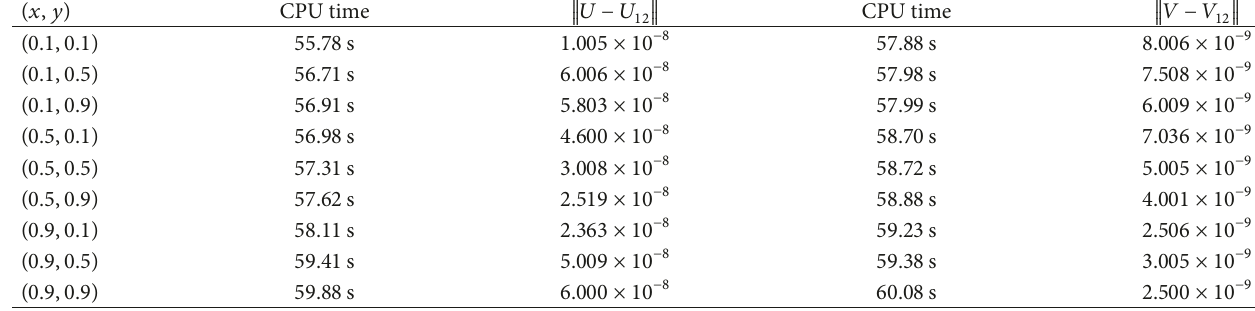
Table 2: Absolute error and CPU times at various values of (𝑥,𝑦) for 𝐾 = 12 in 𝑈(𝑥,𝑦) and 𝑉(𝑥, 𝑦) of Problem 1.